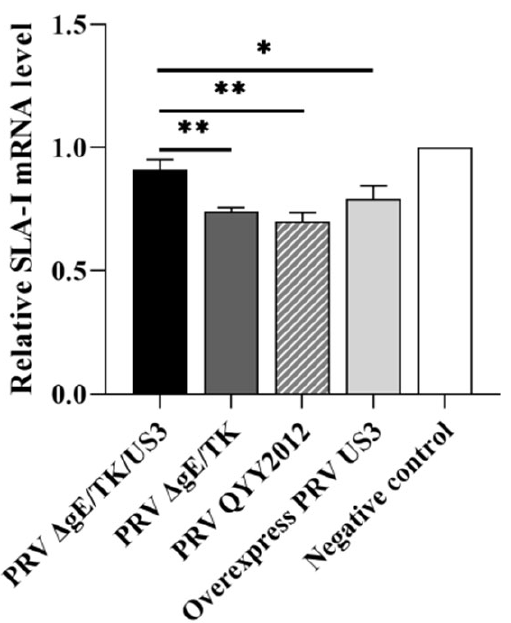
Figure 5. The expression level of SLA ‐ I in ST cells infected with different PRV strains.ST cells were inoculated with PRV QYY2012, PRV Δ gE/TK or PRV Δ gE/TK/US3 strains, and pUS3 plasmid was overexpressed in ST cells. At 6 h after infection or transfection, RNA in infected ST cells was ex ‐ tracted and detected by RT ‐ qPCR using primers SLA ‐ I qF/R. Data was presented as mean ± SD.* p < 0.05, ** p <